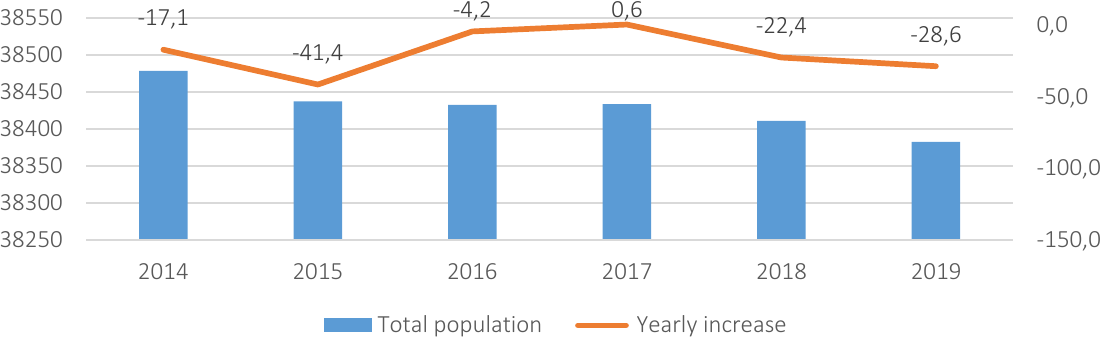
Table 1. Persons authorized to practice the medical profession as of December 31, 2019